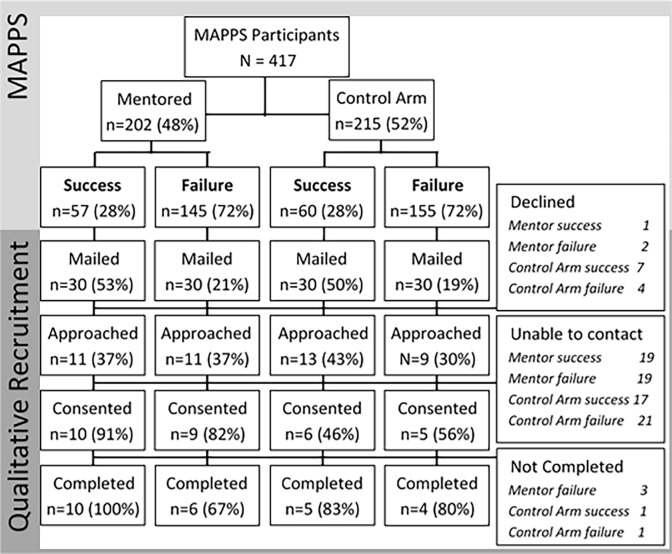
Participant flow.